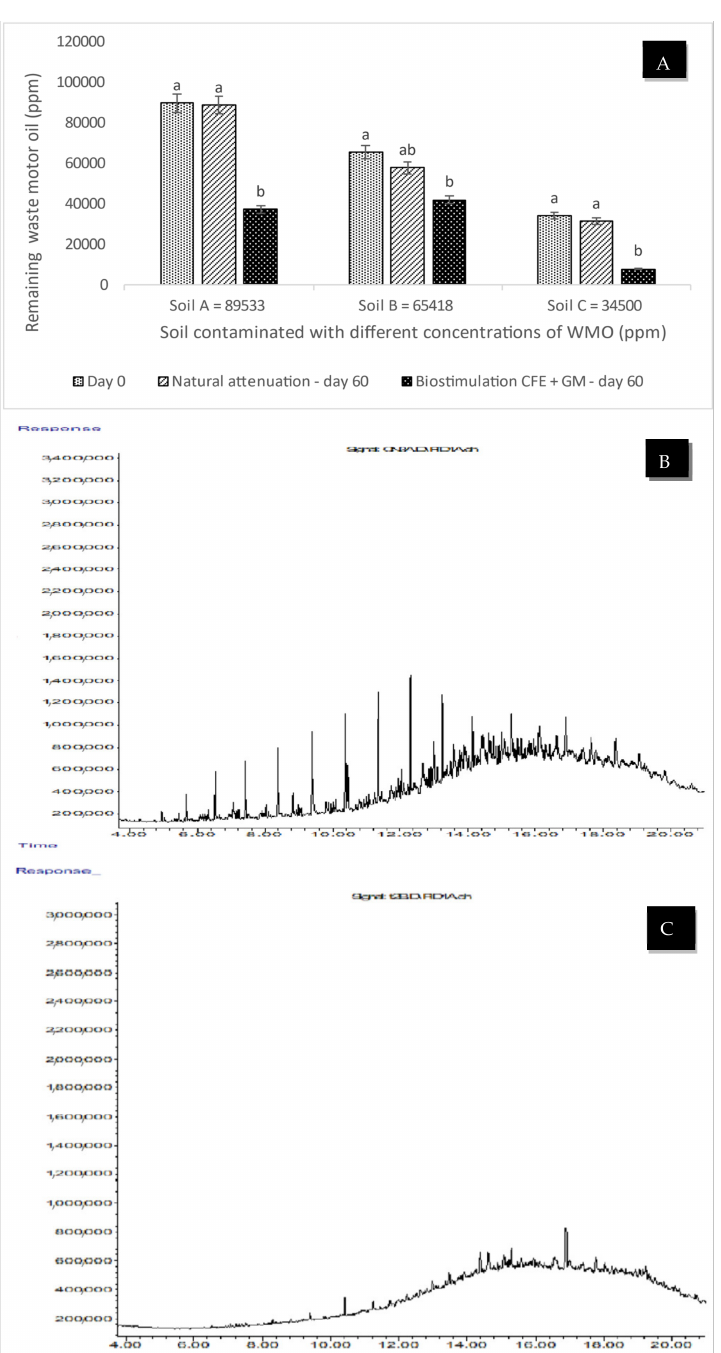
Figure 1. Concentration of remaining waste motor oil in agricultural soil biostimulated applied crude fungal extract and Cicer arietinum as green manure ( A ). Chromatogram of hydrocarbons from waste motor oil before biostimulation of soil ( B ). Chromatogram of the disappearance of hydrocarbons in the soil impacted by 34,500 ppm of waste motor oil after biostimulation using crude fungal extract and Cicer arietinum as a green manure ( C ). Notes: CFE = crude fungal extract, GM = green manure. Different letters indicate statistical difference according to ANOVA-Tukey ( p < 0.05). Number of repetitions ( n ) =